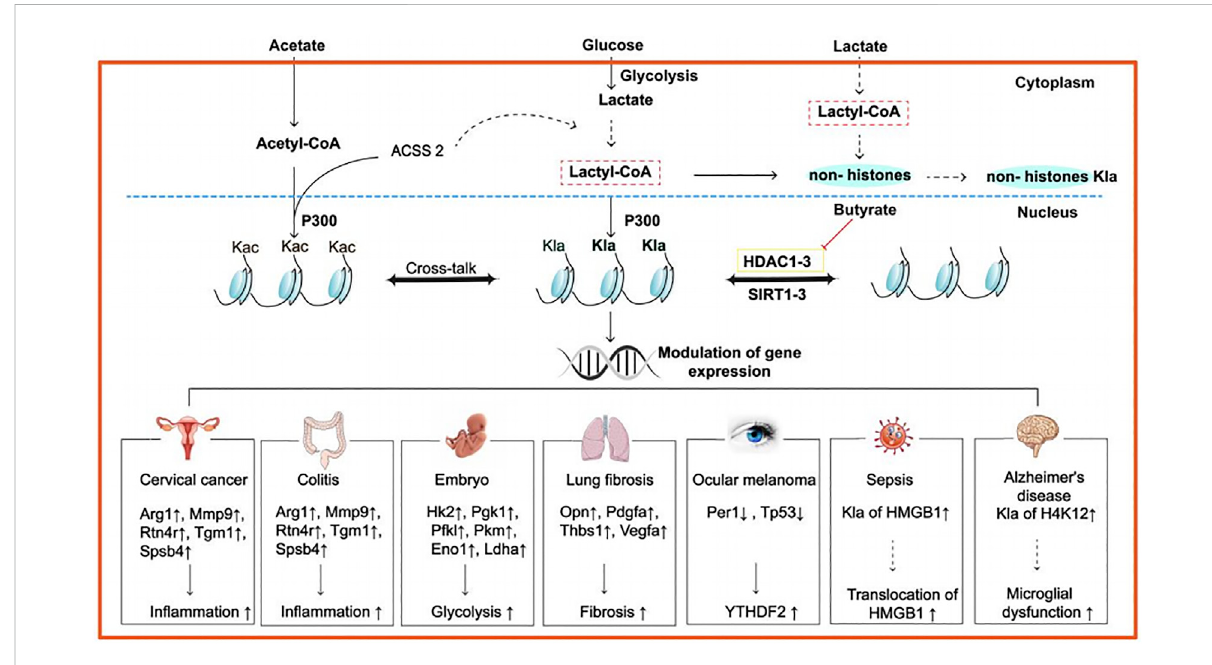
FIGURE 1 Possible mechanism and roles of histone lactylation in some diseases. Lactate derives from the conversion of glucose by glycolysis, and it may synthesize lactyl-CoA, which is hitherto unclear with the ACSS2. Then, the lactyl group is transferred by p300 to Lys lactylations, leading to various physiopathological activities in different diseases. For example, in human cervical cancer and colitis, in fl ammation-related genes such as Arg1, Mmp9,Rtn4r,Tgm1,andSpsb4areupregulated;inembryon,someglycolysis-relatedgenes,includingHk2,Pgk1,Pfk1,Pkm,Eno1,andLdha,are upregulated; in lung fi brosis, fi brosis-related genes such as Opn, Pdgfa, Thbs1, and Vegfa are upregulated; in ocular melanoma, two tumor suppressorgenes,namely,Per1andTp53areupregulated;Insepsis,KlaofHMGB1isupregulated,contributingtothetranslocation ofHMGB1;inAD, Kla of H4K12 is upregulated, resulting in microglial dysfunction. Abbreviations: ACSS2, synthetase short-chain family member 2; p300, an acetyltransferase; Arg1, arginase1; Mmp9, matrixmetalloproteinase9; Rtn4r, reticulon 4 receptor; Tgm1, transglutaminase 1; Spsb4, SPRY domain- and SOCS box-containing protein 3; Hk2, hexokinase 2; Pgk1, phosphoglycerate kinase1; Pfk1, phosphofructokinase-2; Pkm, pyruvate kinase M2;